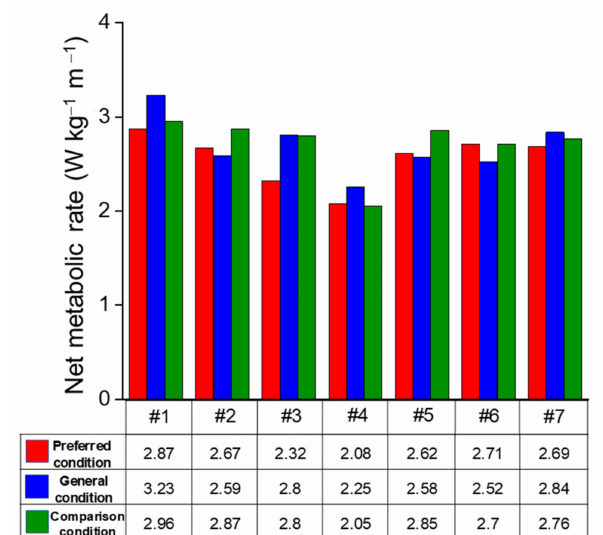
Figure 15. Net metabolic power for each participant under the preferred (red), general (blue) and comparison (green) condition; the table shows the specific values of net metabolic